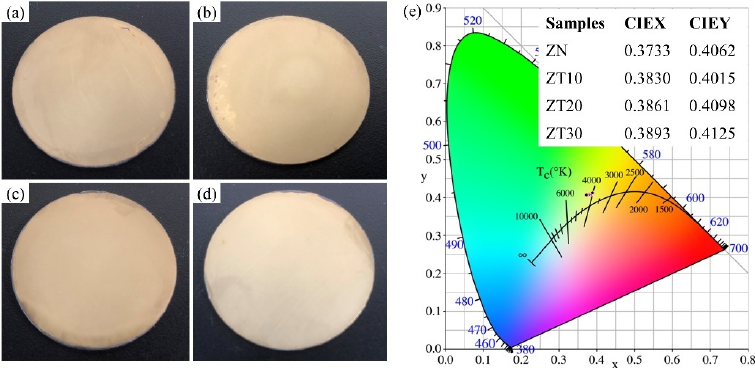
Figure 6. Pictures of the as-prepared ceramics: ( a ) ZN, ( b ) ZT10, ( c ) ZT20, ( d ) ZT30; ( e ) the corre- sponding color coordinates and color temperature diagram.